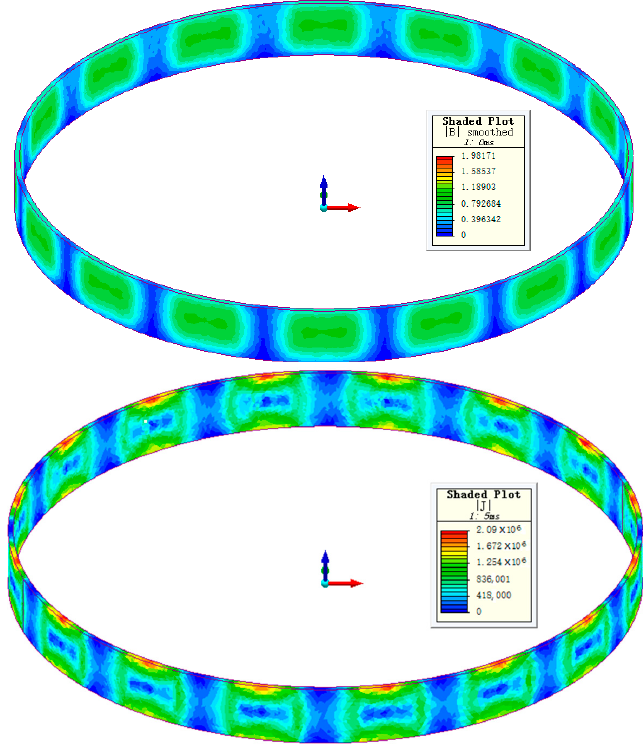
Figure 14. Flux density and eddy current distribution on isolation cover of module 1 at stable zero point.